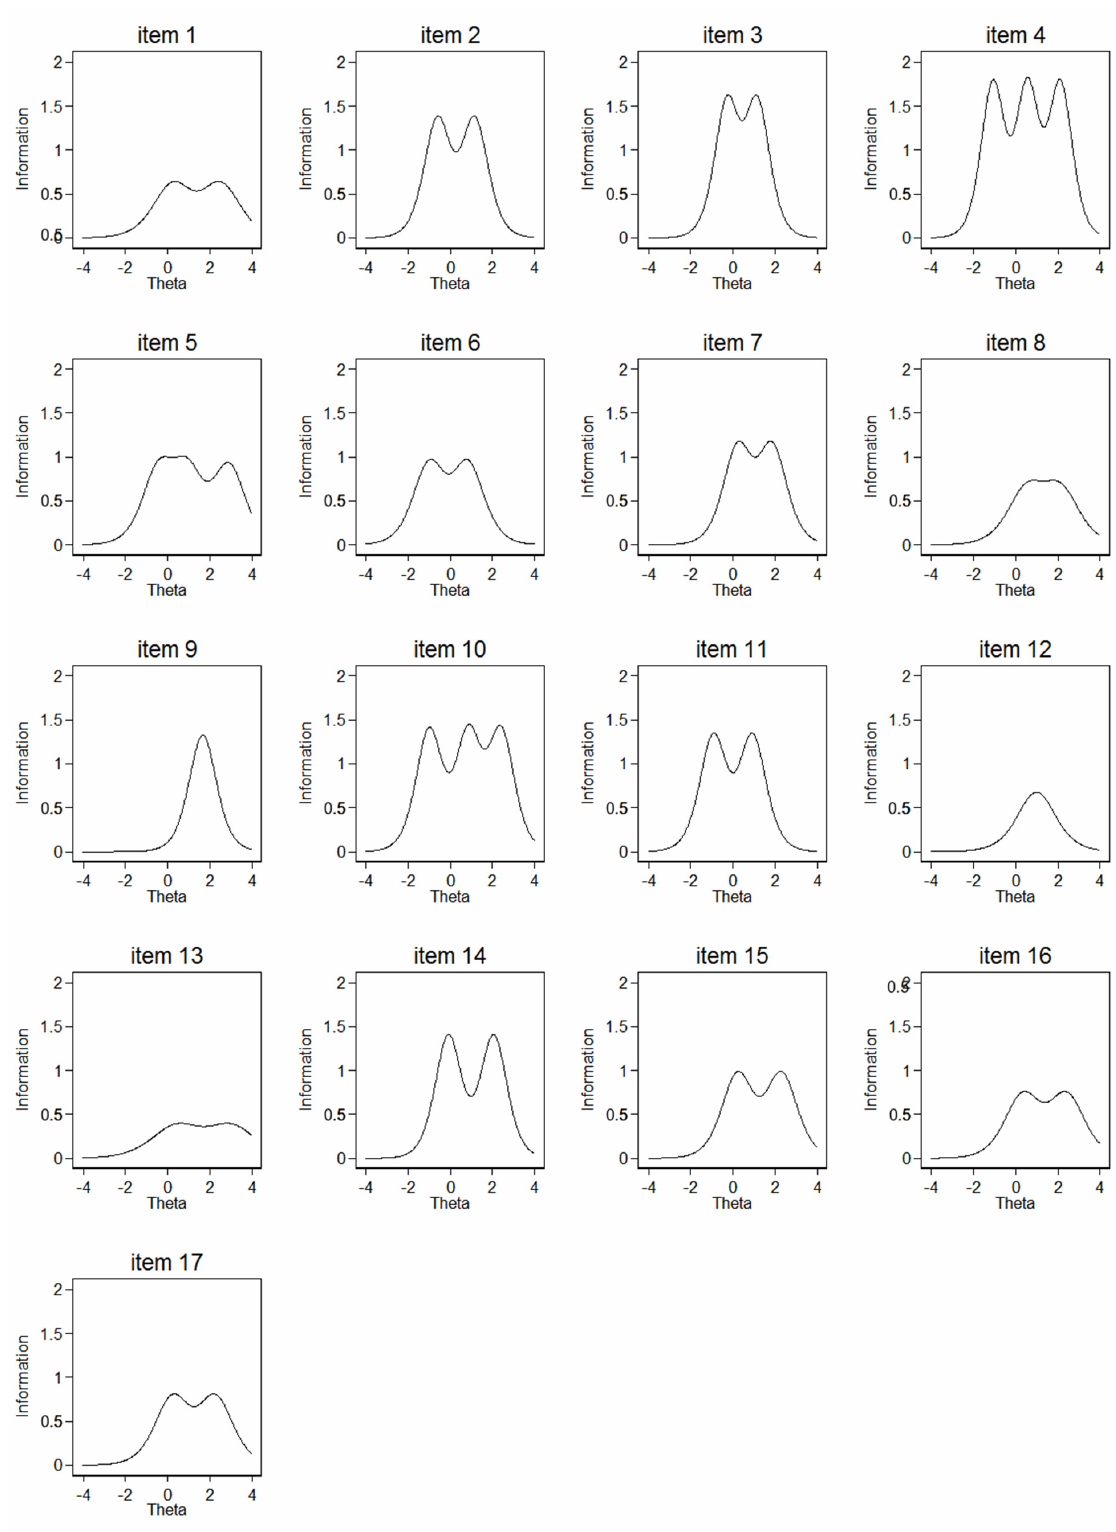
Figure 5. Item information function (IIF) proportions for each of the 17 CVSS items from the graded response model (IRT analysis) of the Italian version of CVSS.